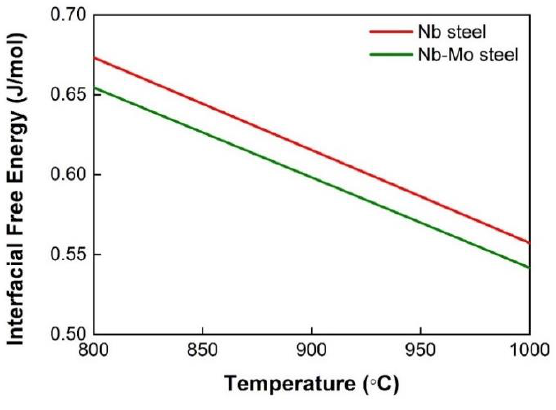
Figure 9. Interfacial free energy of the precipitates formed in austenite for the two